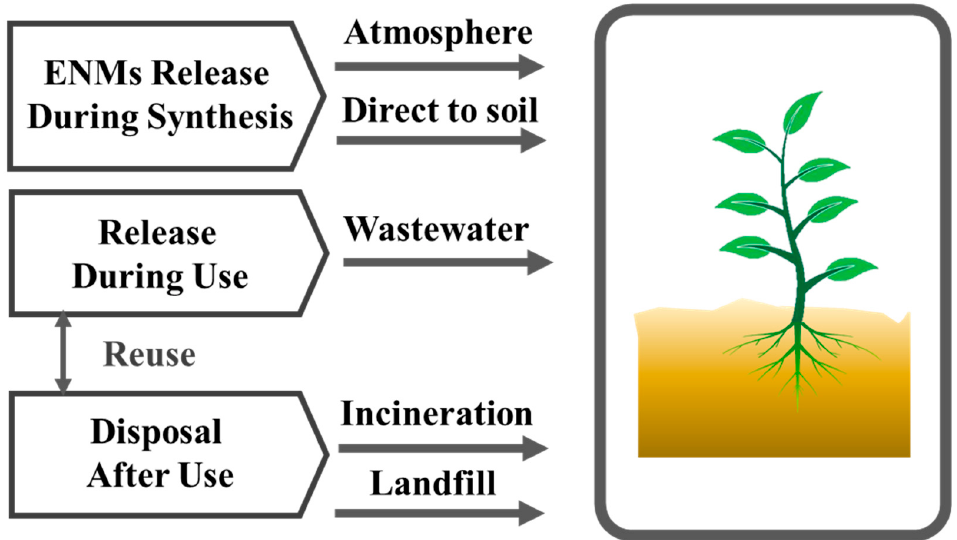
Figure 1. Possible ways of ENMs accumulation in soil.